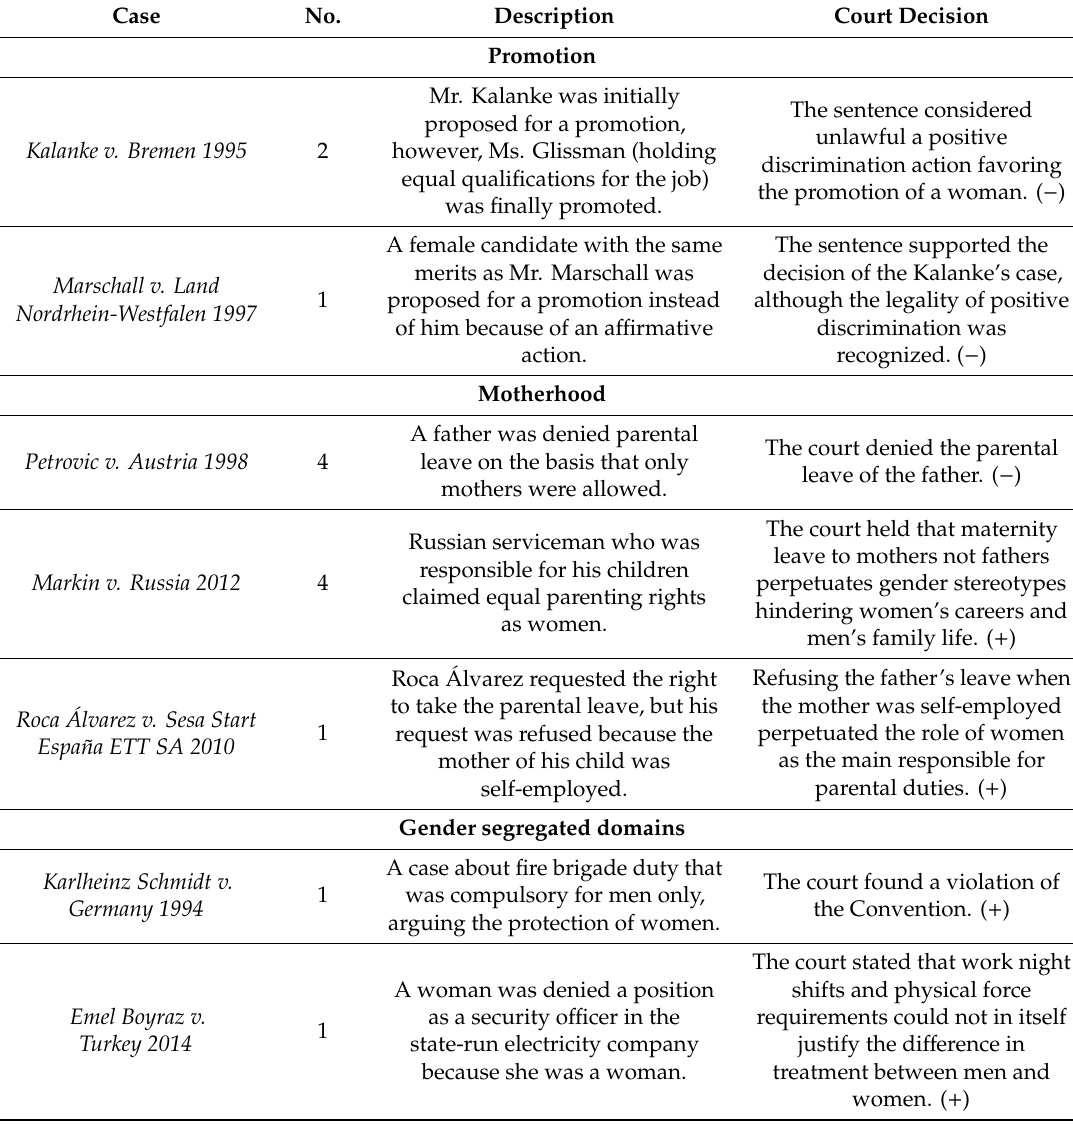
Table 2. Summary of European lawsuit gender